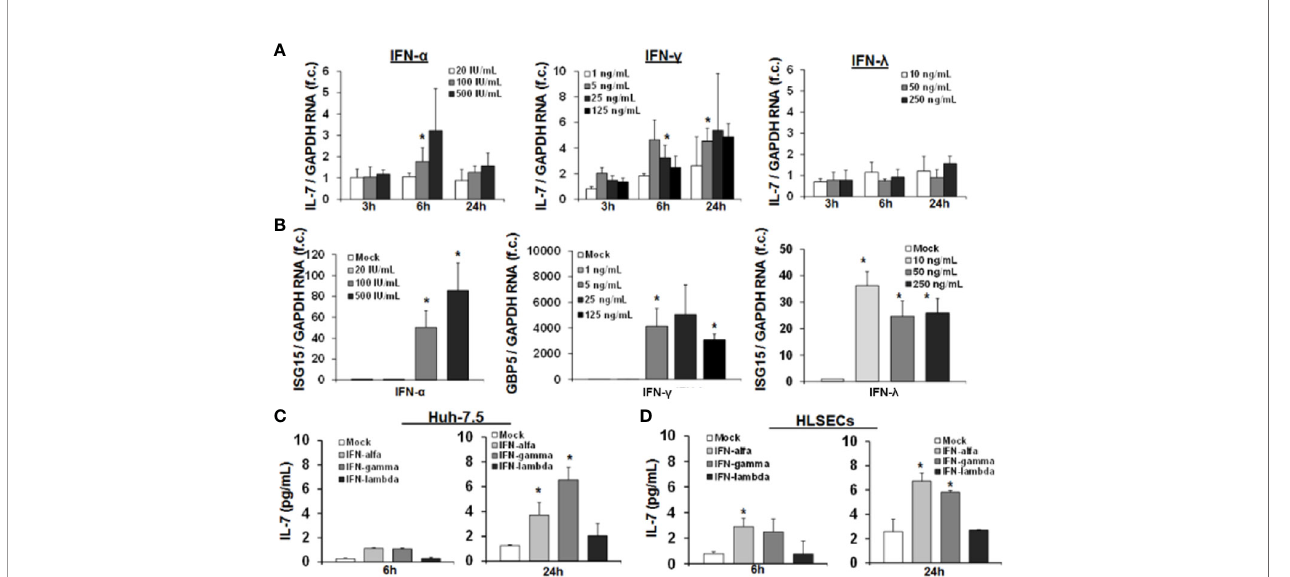
FIGURE 1 | Interferon-(IFN)- a and IFN- g , but not IFN- l , induce hepatic interleukin-7 (IL-7) expression and secretion. (A) Quanti fi cation of IL-7 mRNA levels in relation to housekeeping GAPDH mRNA in Huh-7.5 cells, which were stimulated for the indicated hours with IFN- a (left), IFN- g (middle), or IFN- l 2 (right) at the indicated dosages. IL-7 expression is shown relative to untreated cells. (B) IFN- l signaling is present in Huh-7.5 cells. Quanti fi cation of interferon-stimulated gene (ISG) mRNA levels relative to housekeeping GAPDH mRNA in Huh-7.5 cells, which were stimulated with IFN- a , IFN- g , or IFN- l 2 at the indicated dosages for 6 h. ISG expression is shown relative to untreated cells. (C) Analysis of protein levels of IL- via ELISA in cell culture supernatant of Huh7.5 cells and (D) primary human hepatic sinusoidal endothelial cell (HLSEC), which were stimulated with IFN- a (500 i.E./ml), IFN- g (5 ng/ml), or IFN- l 2 (50 ng/ml) for 6 or 24 h. In (A – D) , standard deviations of three independent experiments (n=3) performed with three replicates each are shown. * P < 0.05 for comparison of the indicated condition with mock. f.c., fold change. IU, international